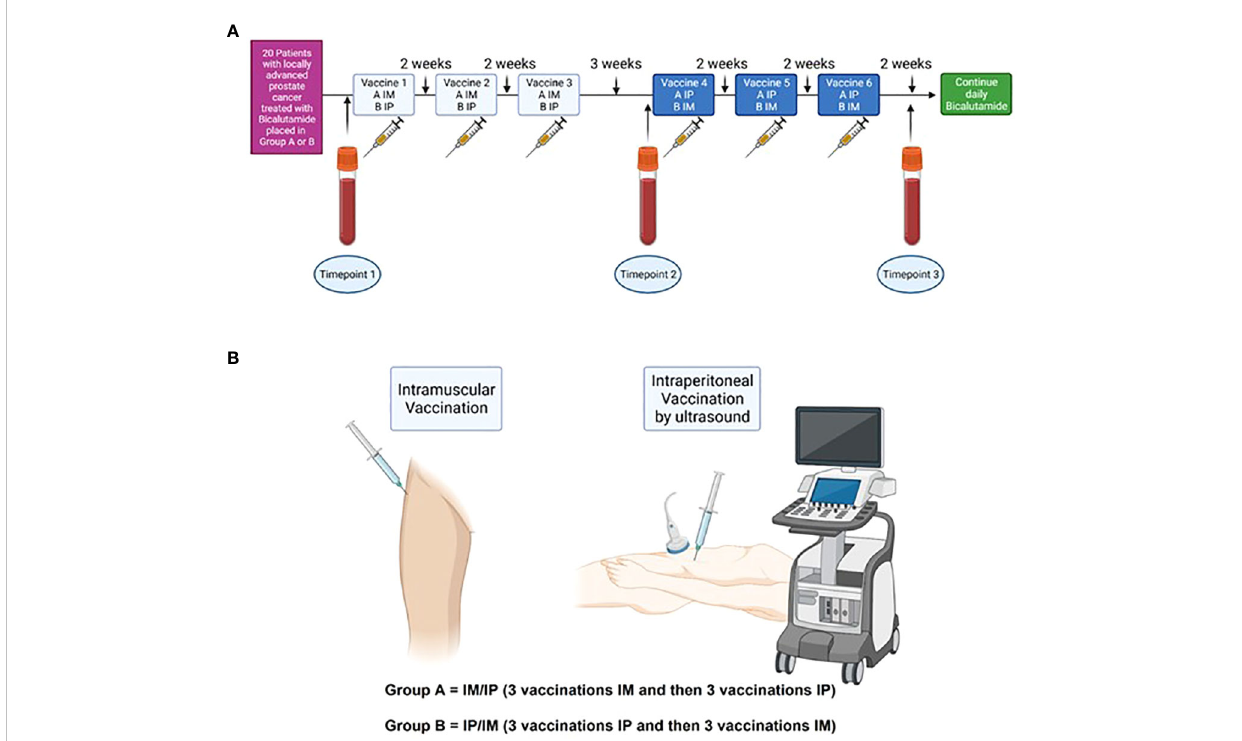
FIGURE 1 Study timelines (A) 20 patients with locally advanced prostate cancer were included and divided into two groups. Group A received three vaccines IM and then three vaccines IP, whereas Group B received the vaccines vice versa. At baseline, blood samples were collected (TP1). Treatment with Bcl_XL_42-CAF ® 09b vaccine was initiated shortly after and administered every second week for a total of 6 vaccinations, except between vaccine three and four, where the patient had a three weeks break. Blood samples were collected after three vaccines (TP2) and after six vaccines